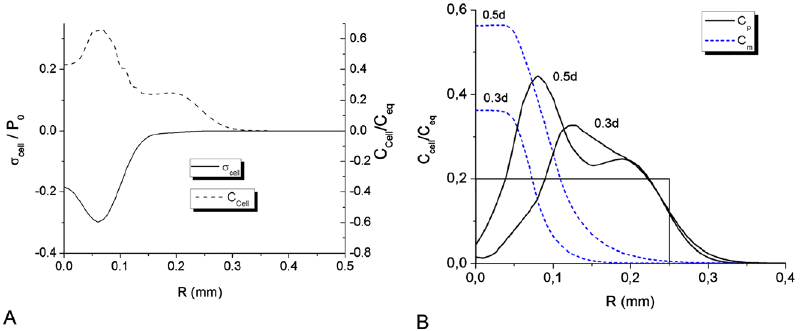
Figure 1: (A) Radial distribution of cell – cell traction forces σ Cell / P 0 and cell concentrations C Cell / C eq for t = 0.3 day; C × 10 5 cells/mm 3 , P eq =3.5 0 = 100Pa.(B) Proliferative (solidlines) andhypoxic(short-dashedlines) celldensitydistributionsfor the moments of time t = 0, 0.3 and 0.5 day. initial distribution ( t = 0) represents proliferative cells only-rectangular area on the graph.